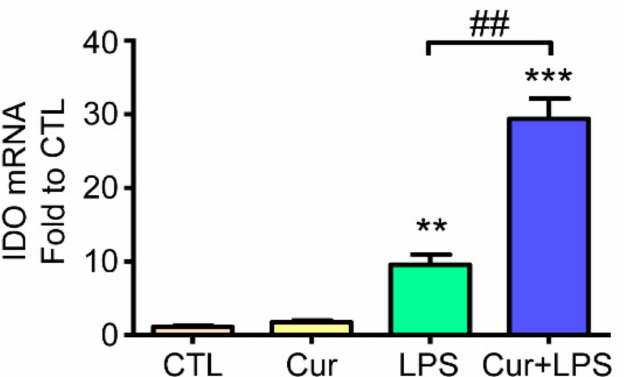
Figure 4. Effects of curcumin and LPS on IDO expression. Rat cultured astrocytes were treated with 1 µ M curcumin, 1 µ g/mL LPS, and their combined treatment for 12 h. Treated cells were harvested and analyzed regarding IDO mRNA expression by RT-PCR. Note that LPS induced IDO mRNA expression and curcumin further enhanced this effect. Data represent the mean ± SEM ( n = 3). Statistical differences were investigated using the one-way ANOVA test and are represented as ** p < 0.01, *** p < 0.001 compared with the control group. ## p < 0.01 compared with the LPS